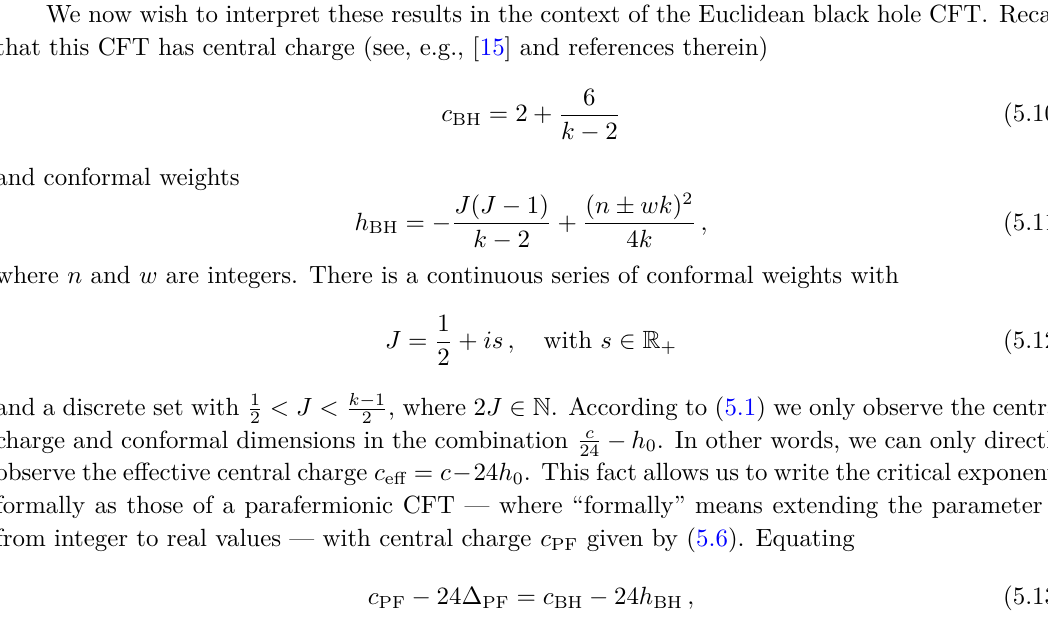
Figure 17 . The scaling behaviour of the gaps generated from the Hamiltonian (3.19) with γ = π in the sector 2 j = 4 . The gaps h are calculated numerically using (5.1). We observe that they i − h 0 converge logarithmically to 0 as we expect from (5.8)–(5.9), and that a large (presumably